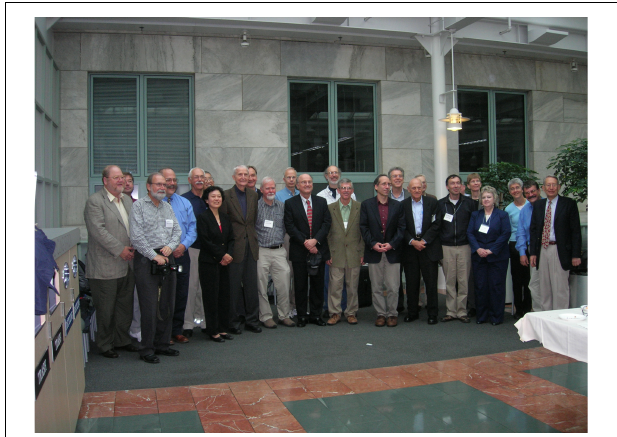
FIGURE 4 | The Kennedy “Clan” on the occasion of his 90th birthday. Eugene Kennedy (1919–2011) is 3rd from the left in the front row. The gathering was in October 2009 at Harvard Medical School. Pictured are former graduate students, postdoctoral fellows and scientific associates of Eugene Kennedy. Figure and legend reprinted by permission from Elsevier (Dowhan, 2013): Copyright 2013.